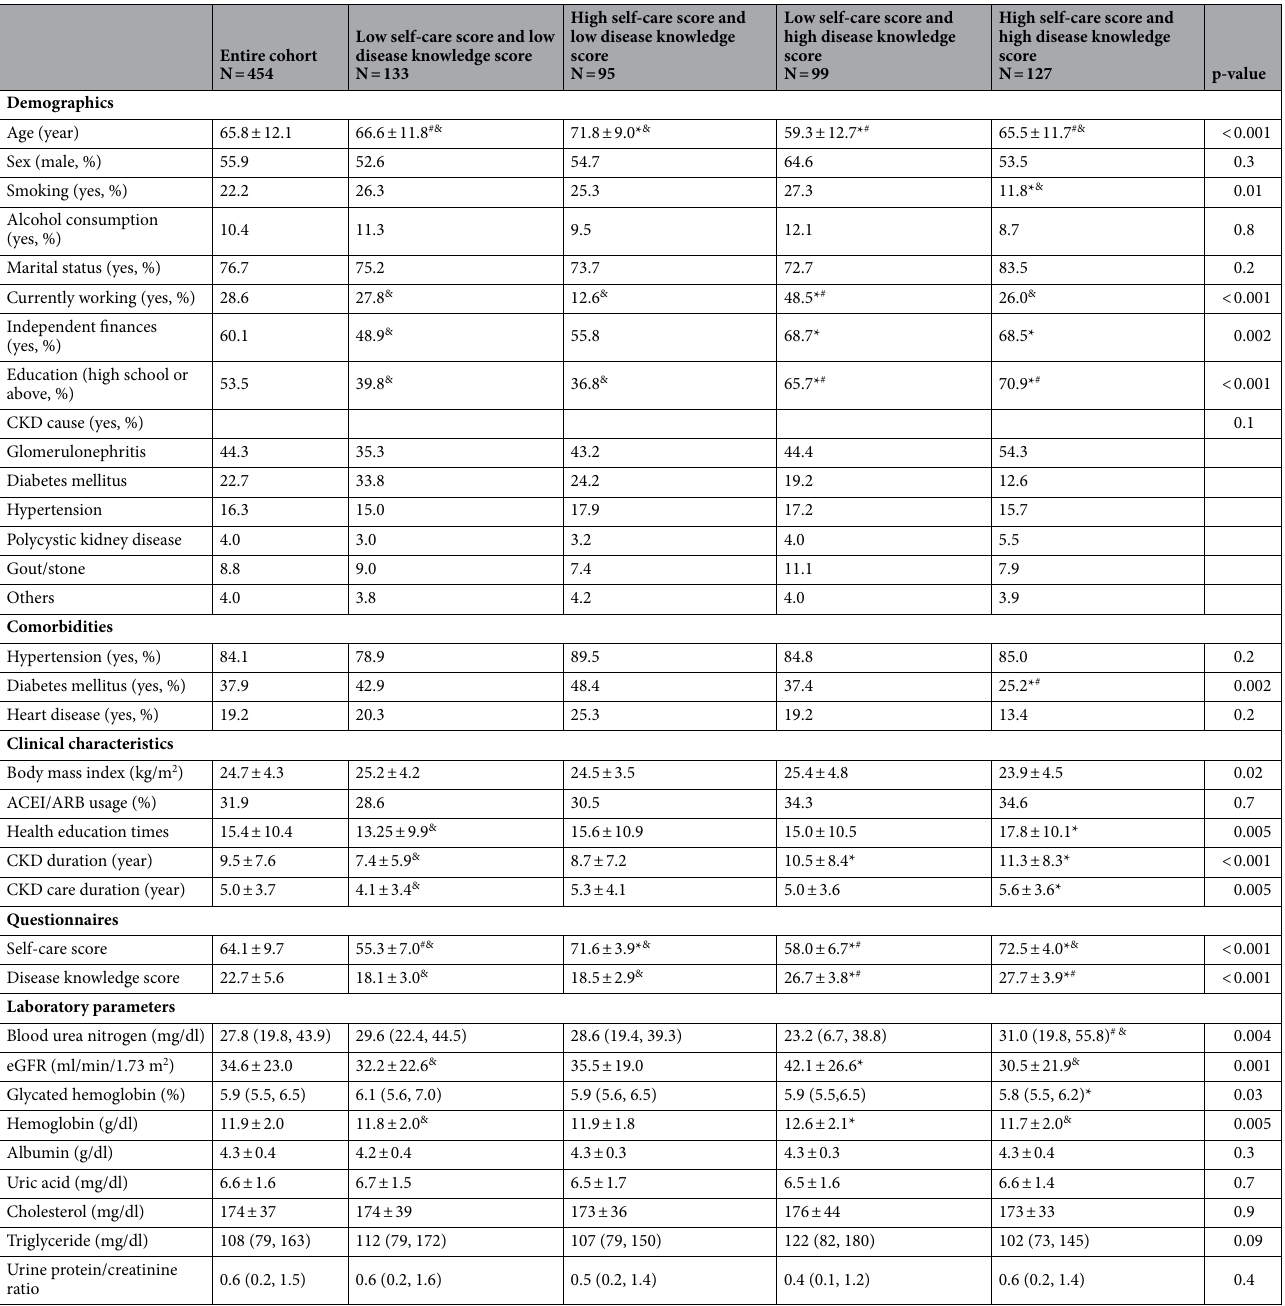
Table 1. The clinical characteristics of study patients stratified by the medians levels of self-care behavior and disease knowledge. Data are expressed as number (percentage) for categorical variables and mean ± SD or median (25th, 75th percentile) for continuous variables, as appropriate. ACEI/ARB, angiotensin converting enzyme inhibitors/angiotensin II receptor blockers; eGFR, estimated glomerular filtration rate. Low self-care as less than median of self-care score (67); High self-care as above median of self-care score (67). Low disease knowledge as less than median of disease knowledge score (22); High disease knowledge as above median of disease knowledge score (22). The missing data included serum albumin (n = 1), blood urea nitrogen (n = 2), uric acid (n = 4), glycated hemoglobin (n = 12), and urine protein-creatinine ratio (n = 1). * P < 0.05 compared with low self-care score & low disease knowledge score; # P < 0.05 compared with high self-care score and low disease knowledge score; & P < 0.05 compared with low self-care score and high disease knowledge